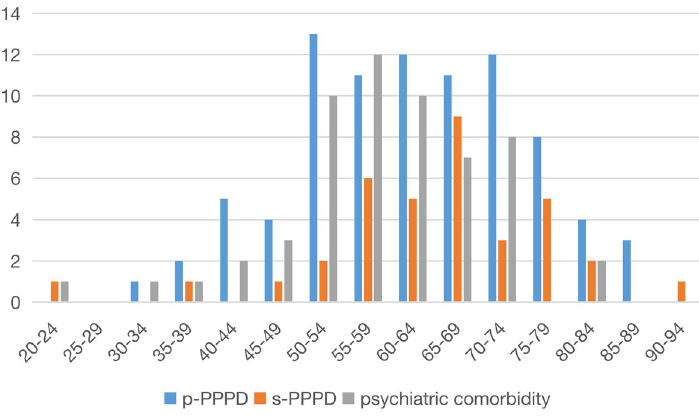
Figure 3. Number of patients with p-PPPD, s-PPPD and psychiatric comorbidity in each age